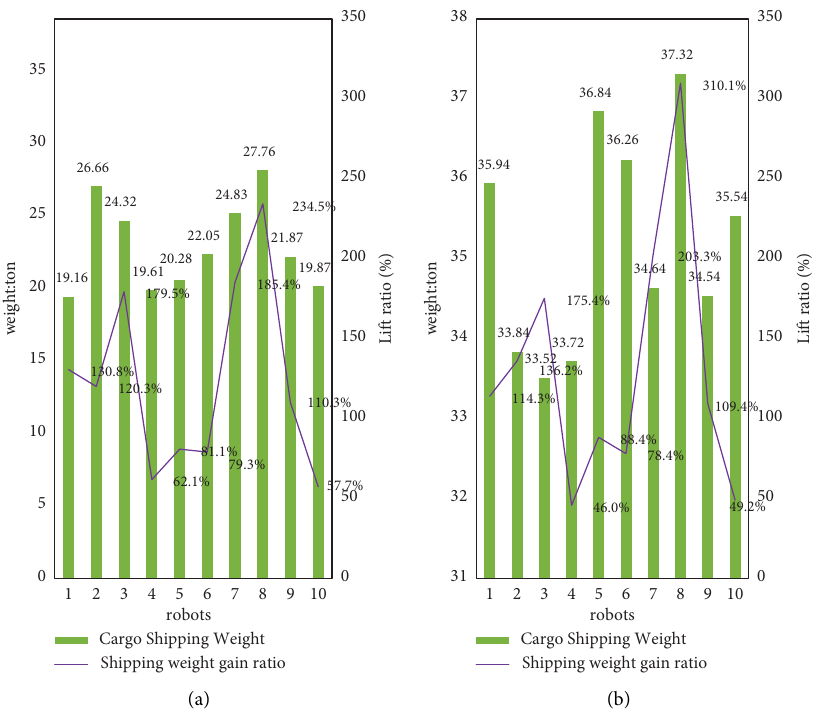
Figure 5: Changes in logistics transportation volume. (a) Te frst set of experiments. (b) Te second set of